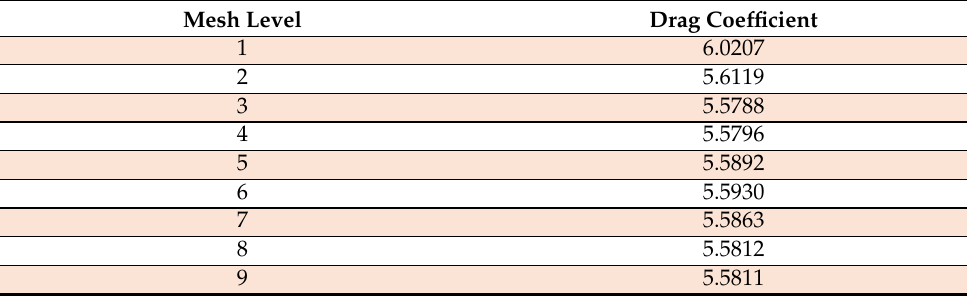
Table 10. Drag coefficient data for Case-V with PVP.